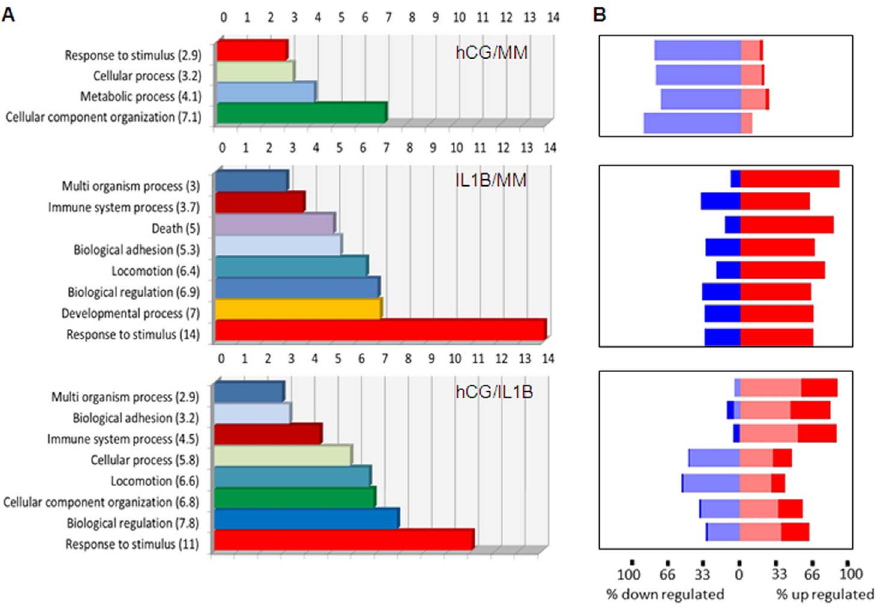
Figure 2. Enrichment score of biological processes. A) GO analysis was used to identify the main biological processes targeted by gene lists and significantly modulated by each treatment. Each functional group was assigned with a GO enrichment score that was calculated using a chi2 test. B) A forest plot using the same gene list was also generated to show the percentage of differentially expressed genes that were up-regulated (red) or down-regulated (blue) for each biological process. Light color: gene populations with a fold change ranging from 1.5 to 2. Dark color: gene populations with a fold change above 2. Data were obtained with ESC cultures issued from 3 different subjects.